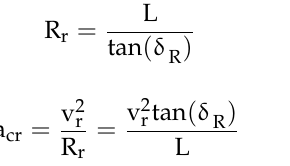
Figure 3. Side view and rear view of the two-wheeled motorcycle equipped with SGCMG.